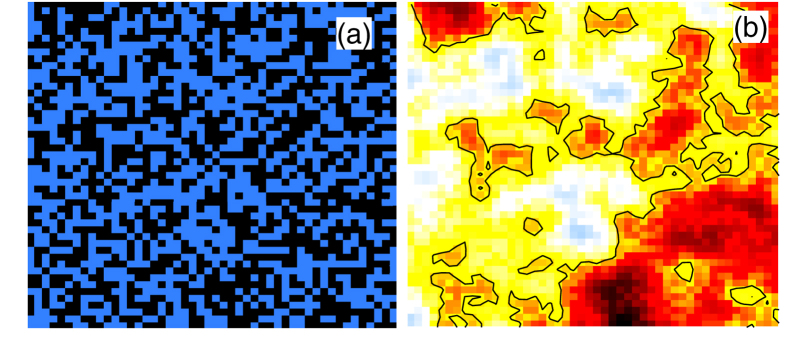
Blow-up of highlighted areas of frames(a) and (b) of Fig. 1.